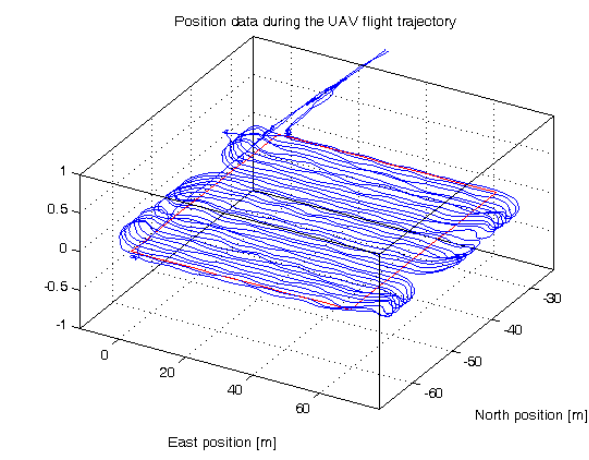
Figure 7: The actual recorded UAV position data during the aerial magnetic scanning mission.